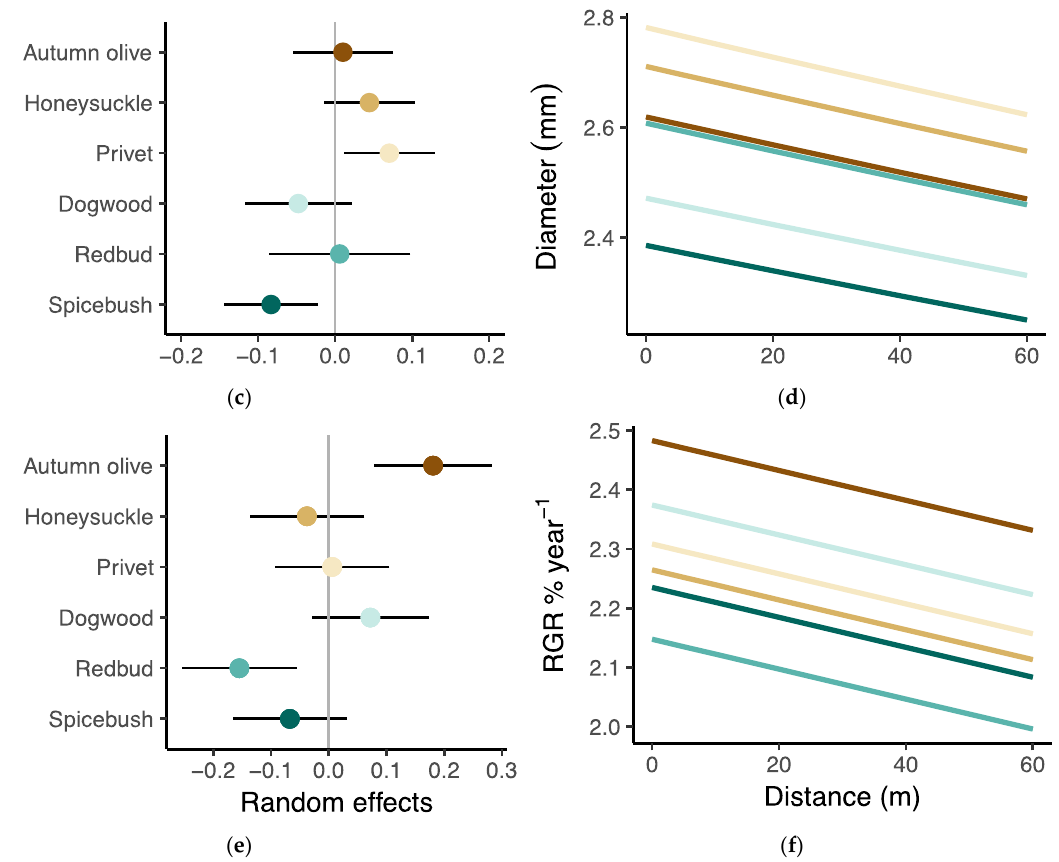
Figure 7. Results from linear mixed effects models of growth measurements. ( a , c , e ) Differences between the overall model intercept and the estimated intercept for each species ±95% confidence intervals, and ( b , d , f ) the marginal effect of distance on three of the performance responses, biomass, diameter, and relative growth rate. The brown shading indicates the group of invasive species while the blue shading indicates the group of native species.